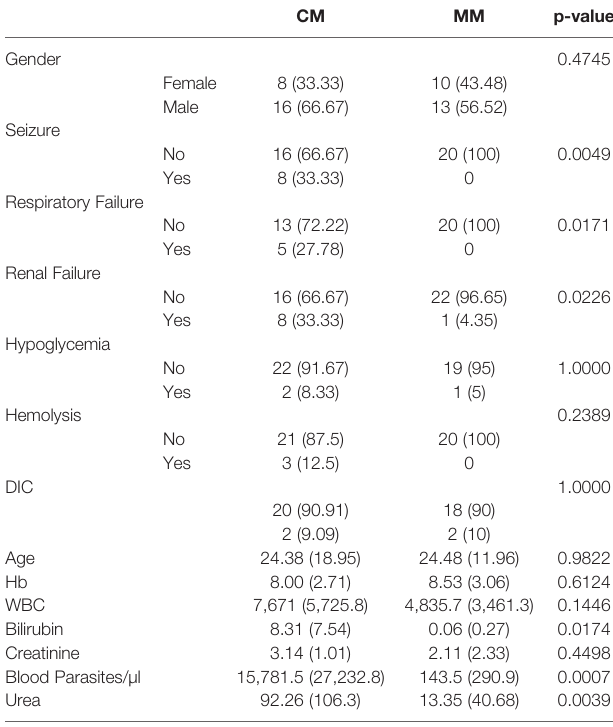
TABLE 1 | Clinical characteristics in different malaria